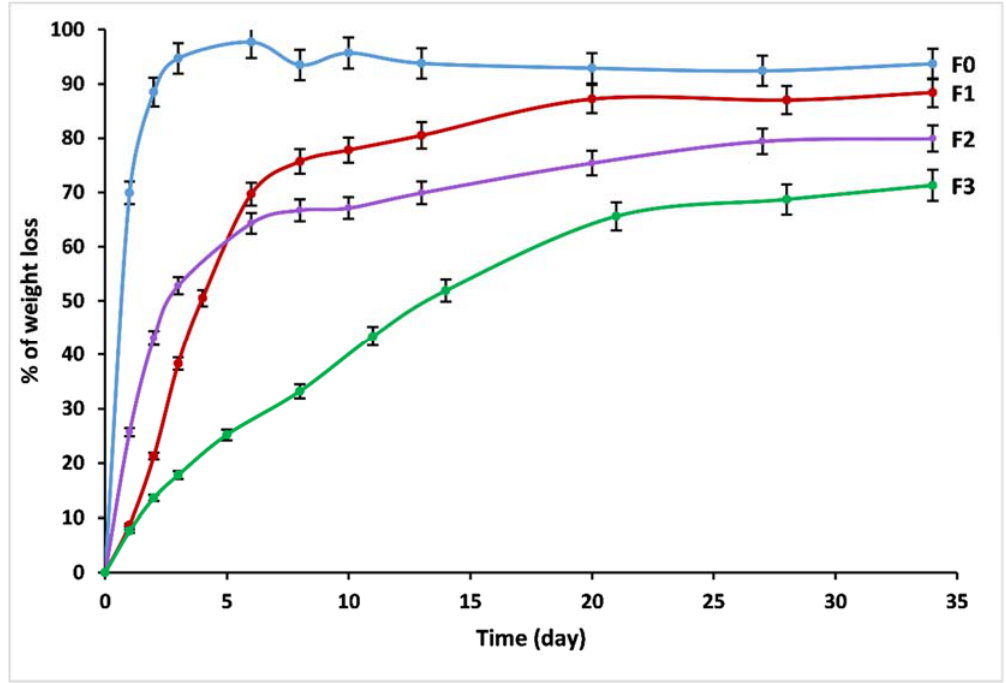
Figure 7. Trend of weight loss of F 0 , F 1 , F 2 and F 3 glasses.